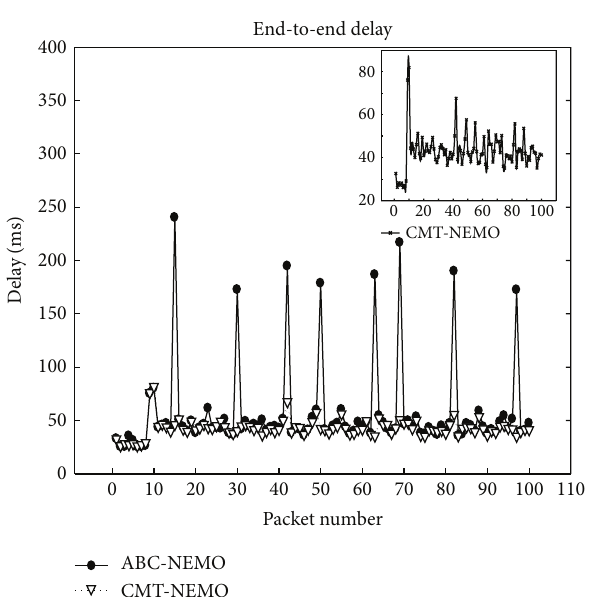
Figure 20: Comparison of jitter (IPDV).